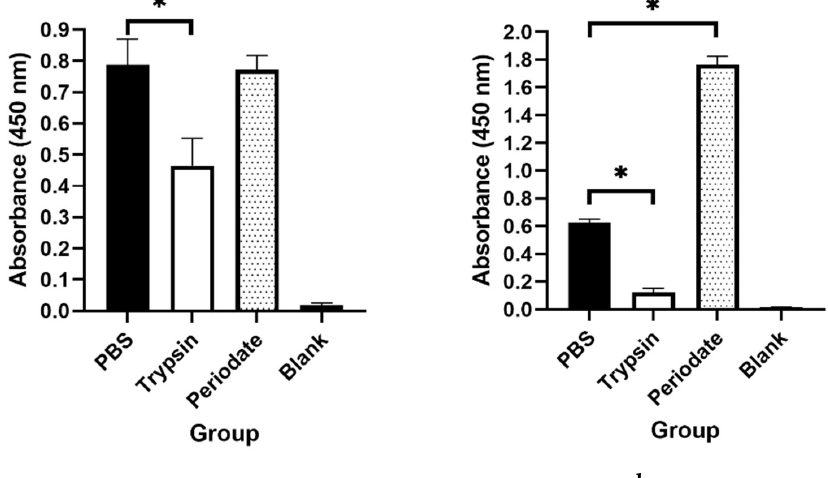
Figure 4. Characterization of Aspergillus fumigatus antigens recognized by mAbs 1D2 and 4E4. The A. fumigatus cell wall proteins (CWPs) were separated by SDS ‐ PAGE and stained by Coomassie Brilliant Blue (CBB) ( a ). By Western blotting ( b ), both mAb 1D2 and 4E4 showed a diffuse signal to A. fumigatus CWPs with molecular weight exceeding 37 kDa, particularly some visible bands with molecular weight between 37 kDa and 75 kDa.